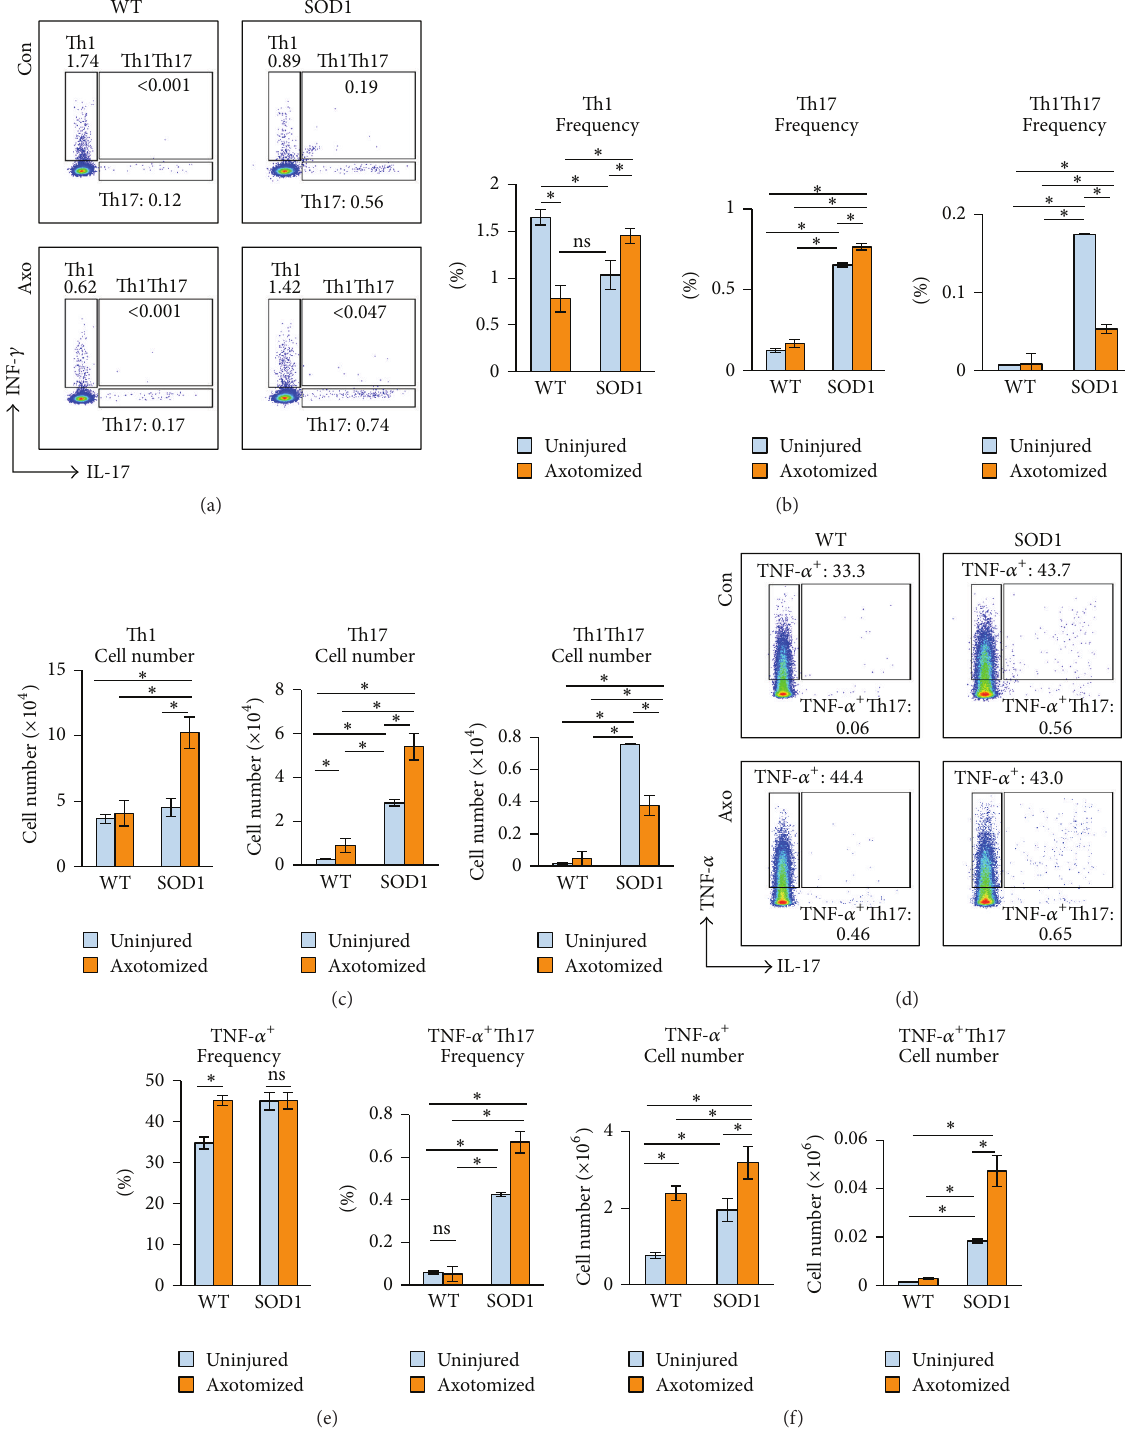
Figure 2: Th17 cell responses in SOD 1 G 93 A mice. CD4 + T cells were isolated from dCLN from uninjured (Con) and axotomized WT and SOD 1 G 93 A mice at 7 dpa ( 𝑛 = 4 mice/group). (a) Intracellular staining was performed for IFN- 𝛾 and IL-17 and analyzed using FACS. (b) The averaged percentages of Th1, Th17, and Th1Th17 cells in each groups were calculated and compared. (c) The averaged total number of Th1, Th17, and Th1Th17 cells in each groups was calculated on the basis of the total number of corresponding dCLN and their percentages. (d) Intracellular staining was performed for TNF- 𝛼 and IL-17 and analyzed using FACS. (e) The averaged percentages of TNF- 𝛼 + and TNF- 𝛼 + Th17 cells in each groups were calculated and compared. (f) The averaged total number of TNF- 𝛼 + and TNF- 𝛼 + Th17 cells in each groups was calculated on the basis of the total number of corresponding dCLN and their percentages (data are presented as mean ± SD; 𝑛 = 4 mice/group, ∗ 𝑝 < 0.05 ; blue bars represent uninjured animals, whereas gold bars represent animals that have been subjected to